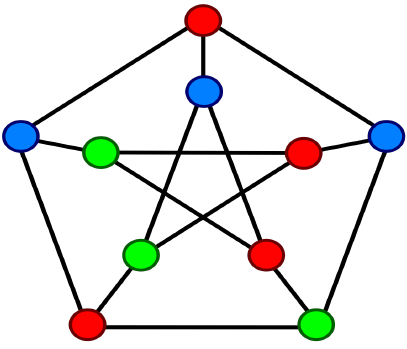
Figure 5. Example of a non-star graph with many junction nodes.